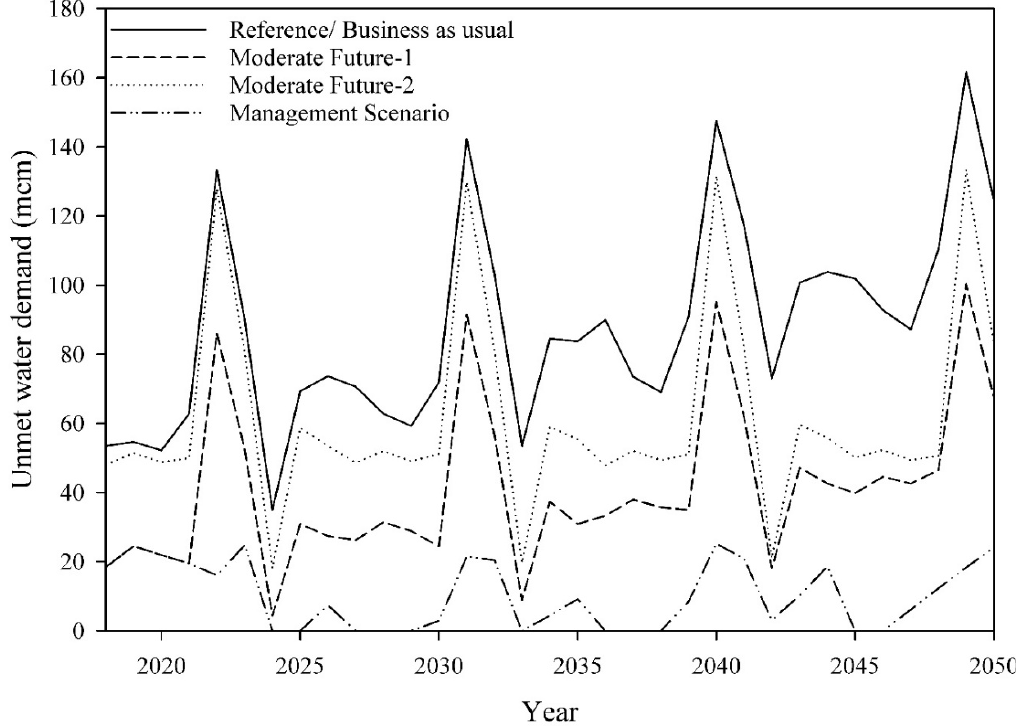
Figure 17. The projection of the “total unmet water demand” under four different prediction scenarios (2014–2050).